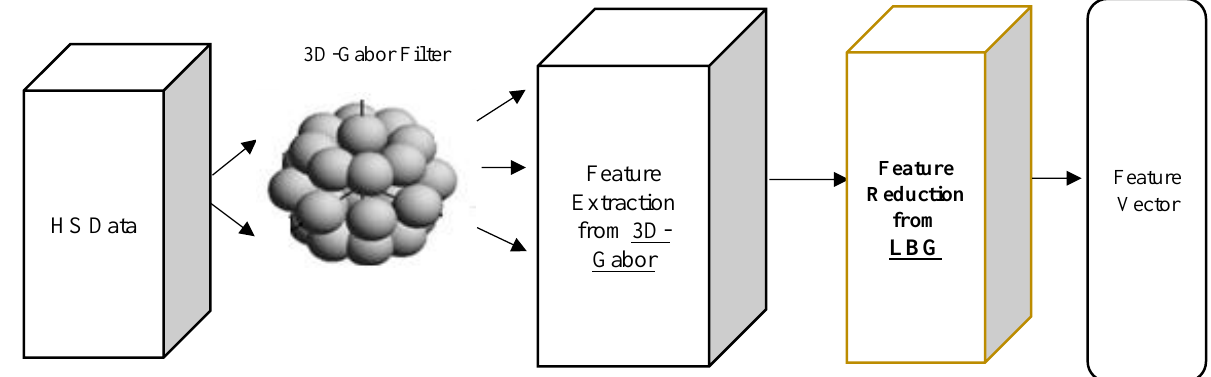
Figure 1. Flowchart of Proposed Method